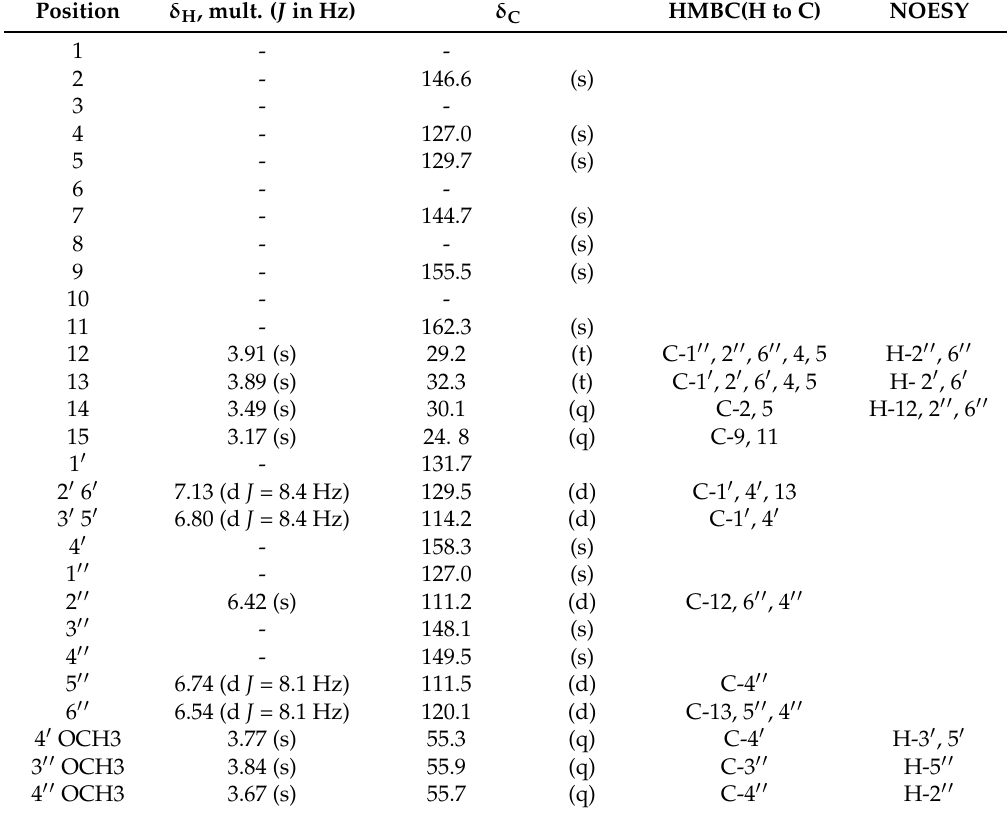
Table 2. NMR data for compound 1 (Recorded in CDCl 3 ) a .